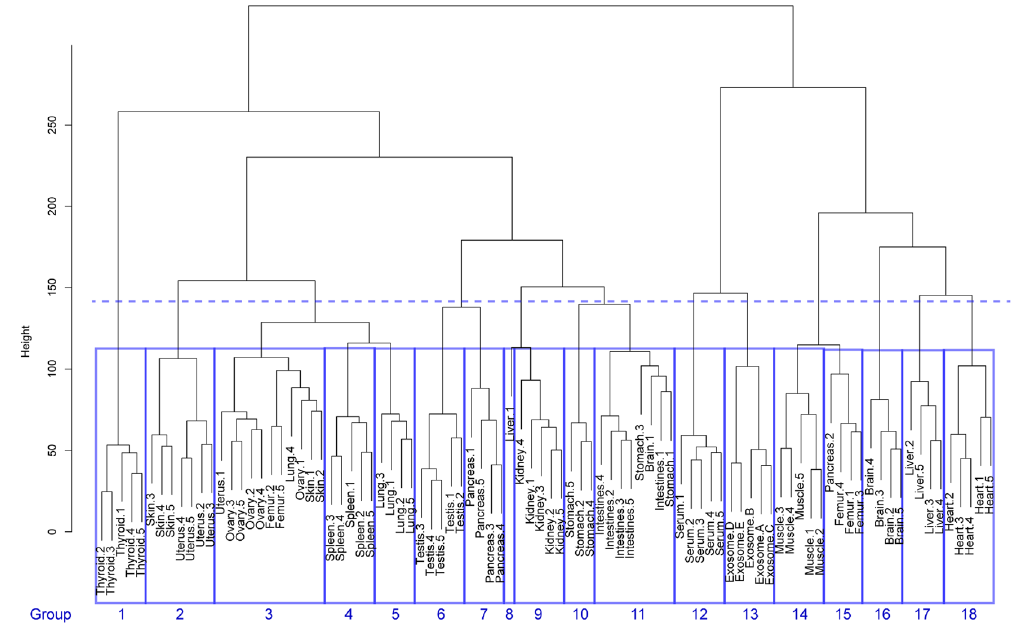
Figure 6. The hierarchical clustering analysis of the mouse N -glycome datasets. The N -glycosylation pattern dissimilarities in all samples were aggregated into 18 groups by using hierarchical clustering method (unsupervised learning). The Canberra distances were used as the dissimilarities among the N -glycosylation patterns in the samples. The dendrogram represents the aggregation by Ward’s method.